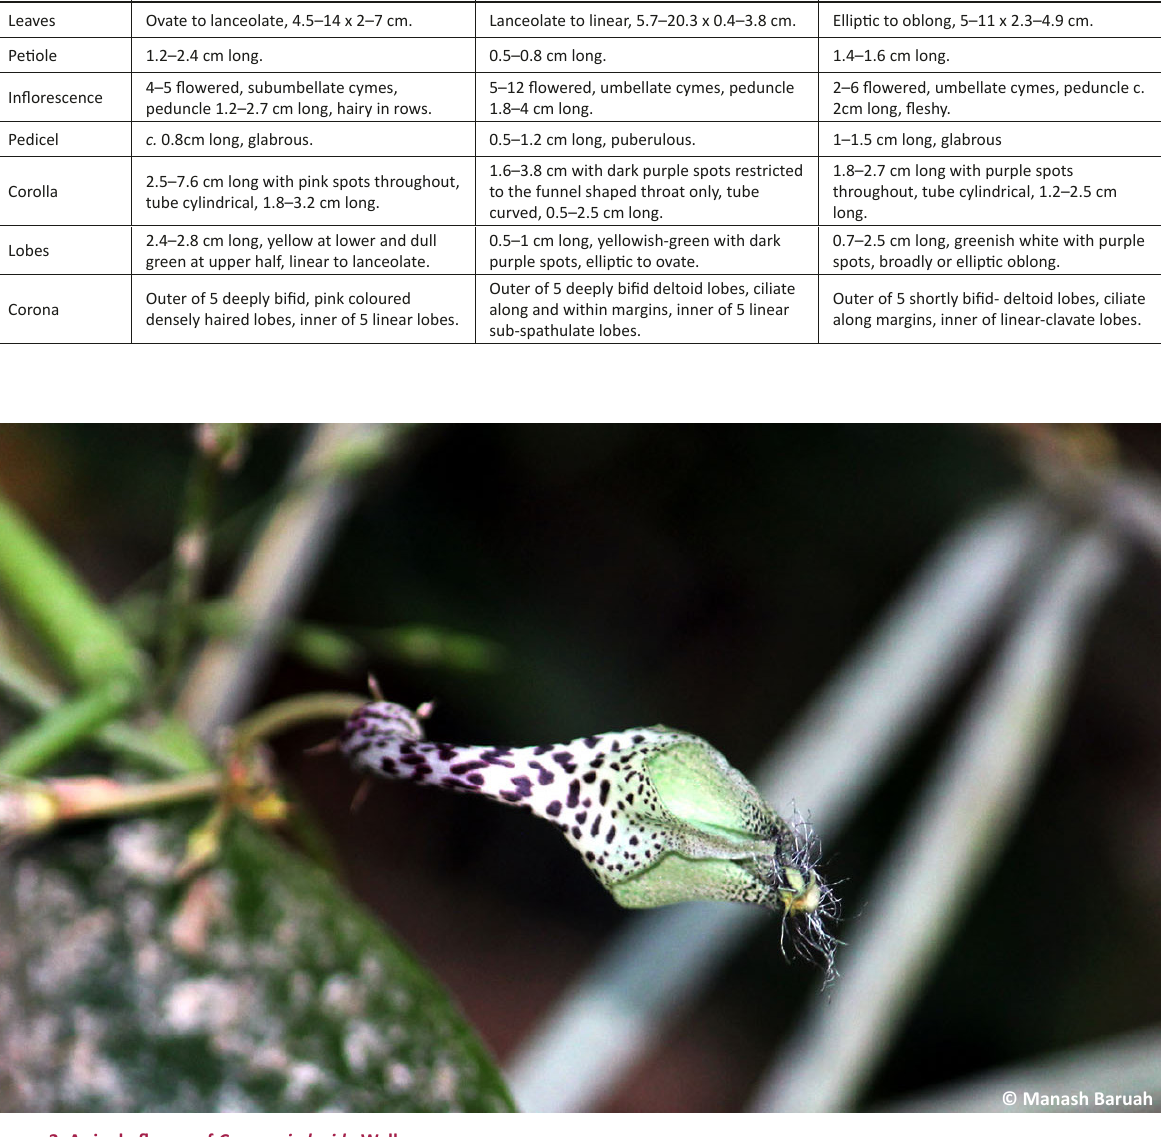
Table 1. A comparative analysis of Ceropegia lucida Wall. with other closely related species of northeastern India. Attributes